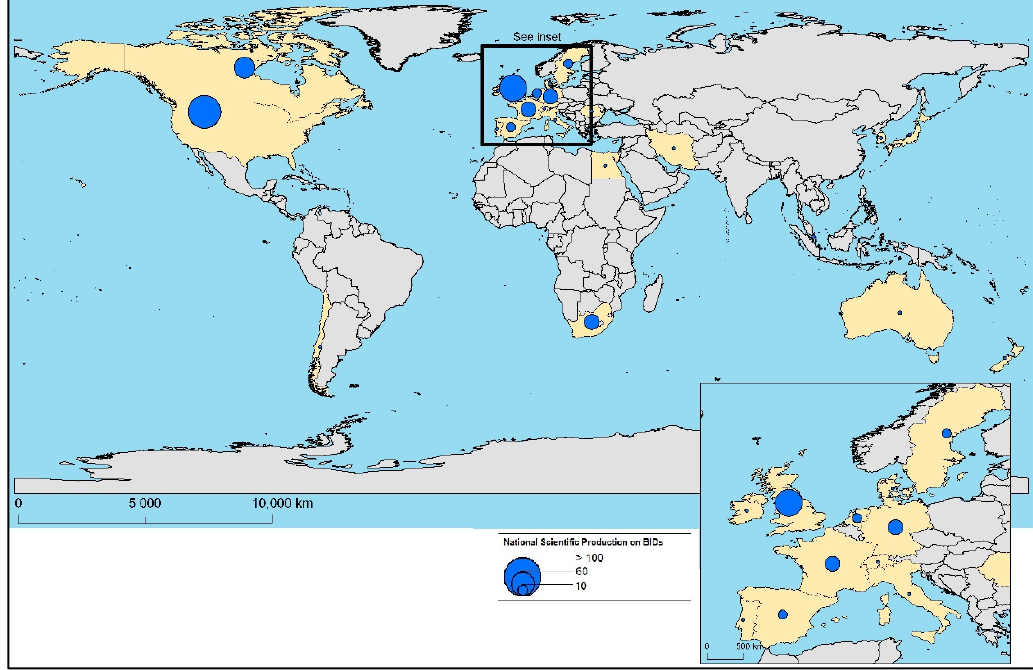
Figure 3. Global mapping of the national production on BIDs, 1979–2021. Table 2. Most prominent academics publishing on BIDs,